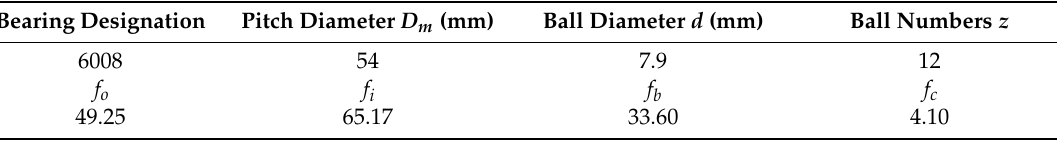
Table 4. Specifications of the supporting bearing.